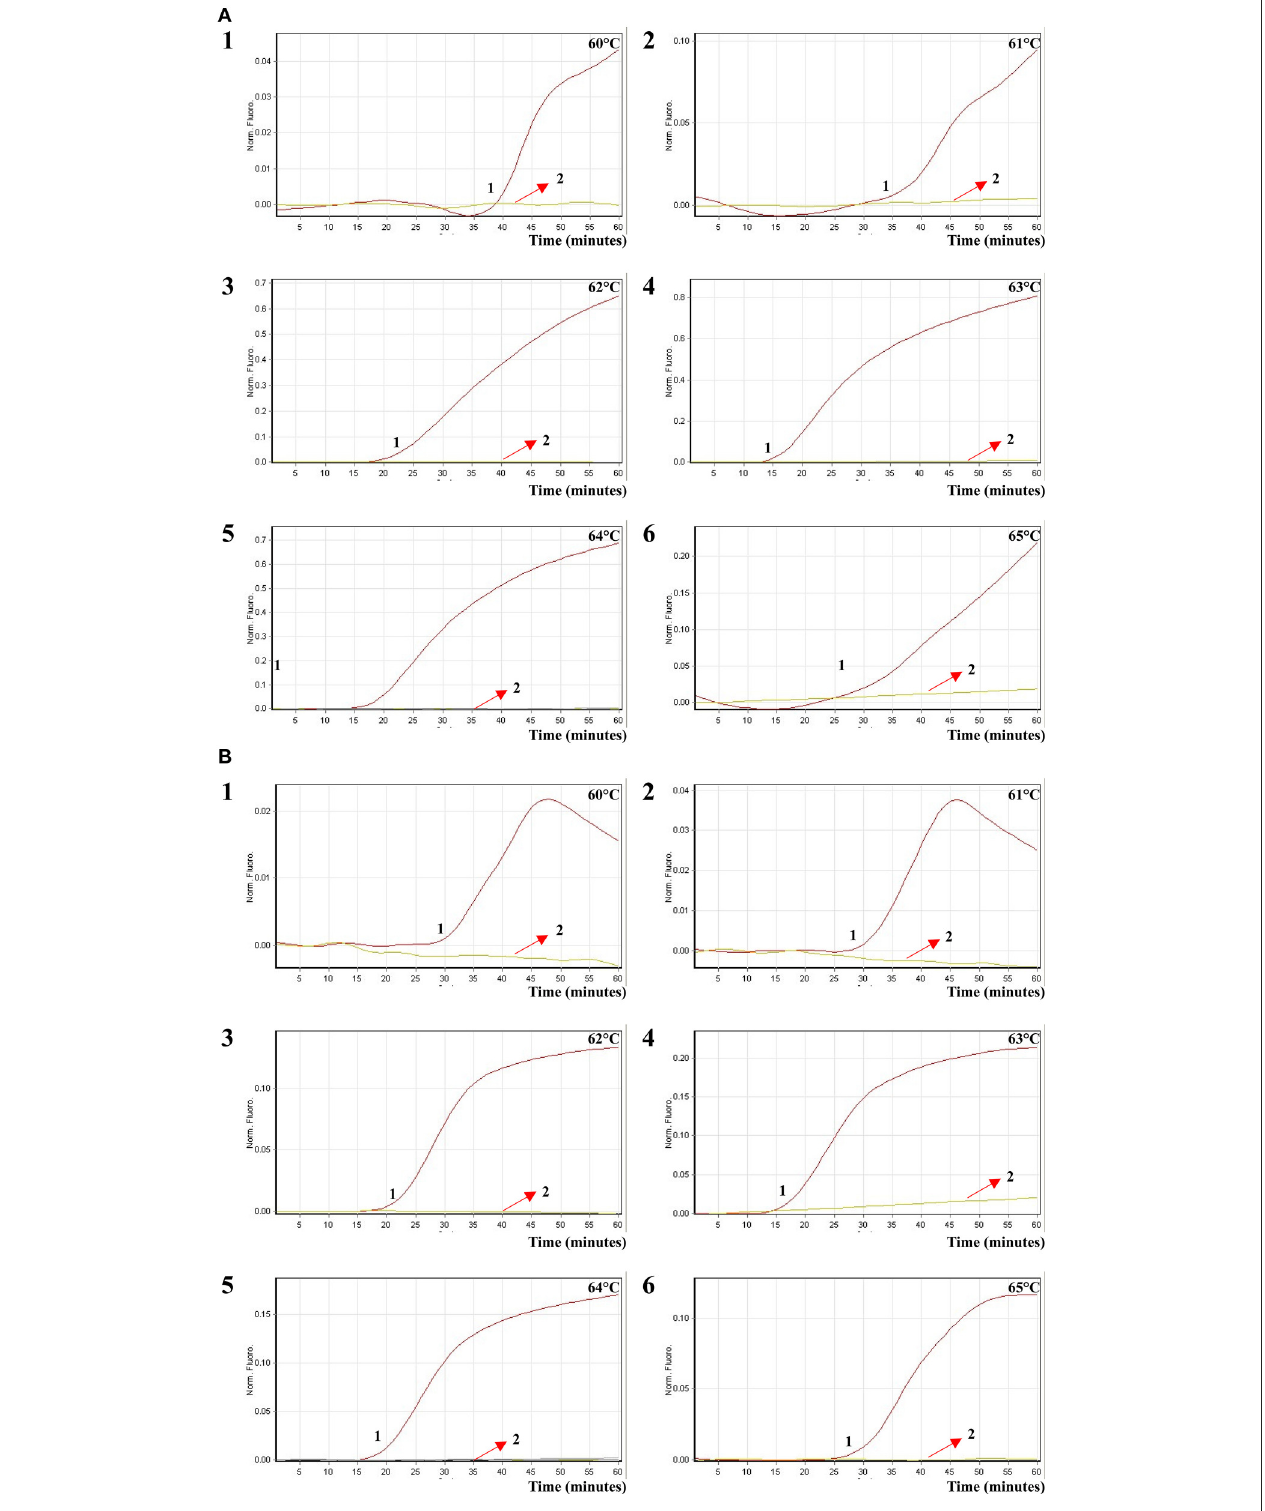
FIGURE 5 | The optimal reaction temperature of the ET-MCDA assay. Two sets of ET-MCDA primers targeting invA and ipaH genes were used in the same reaction tube, (A,B) were simultaneously generated from Cy5 (labeling Sal -E-CP1 of invA ) and Hex (labeling Shi -E-CP1 of ipaH ) channels, respectively. The multiplex ET-MCDA amplifications were monitored by means of real-time format, and the corresponding curves of DNA concentrations were listed. Signal 1 indicates